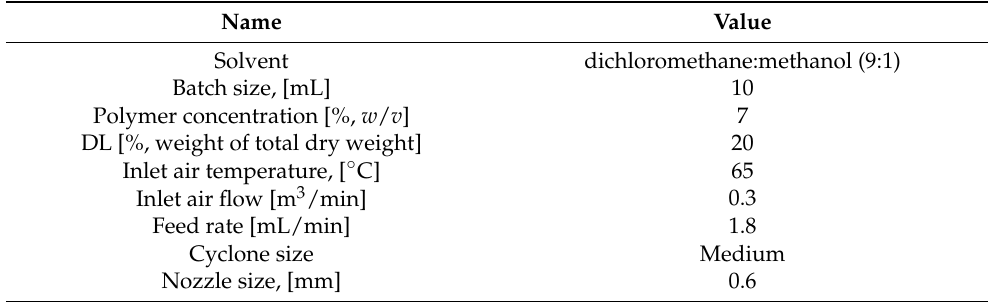
Table 1. Process parameters used for the preparation of ATV-loaded MP by spray-drying process. Name Value Solvent dichloromethane:methanol (9:1) Batch size,